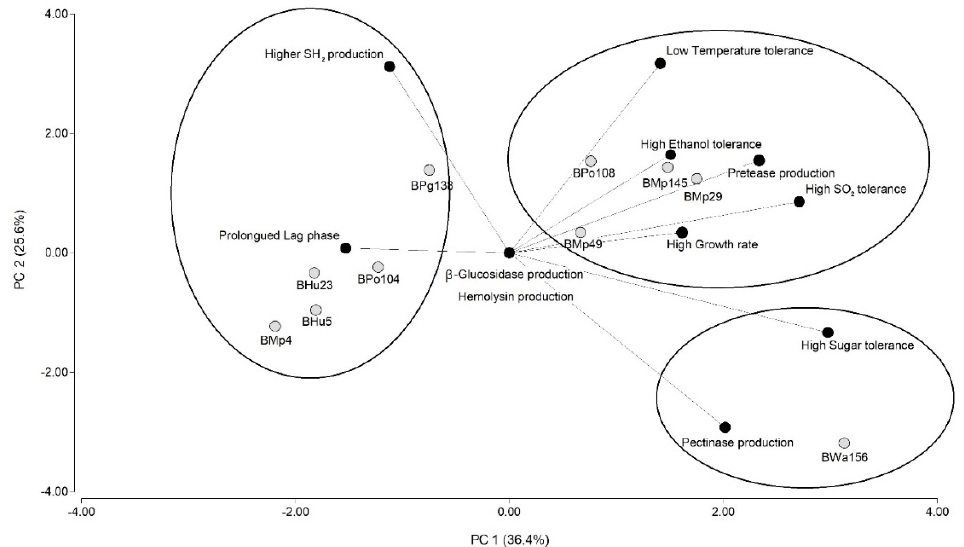
Figure 2. Principal Components Analysis (PCA) of yeast characteristics. References: Ellipses represent clusters obtained from hierarchical cluster analysis (HCA).